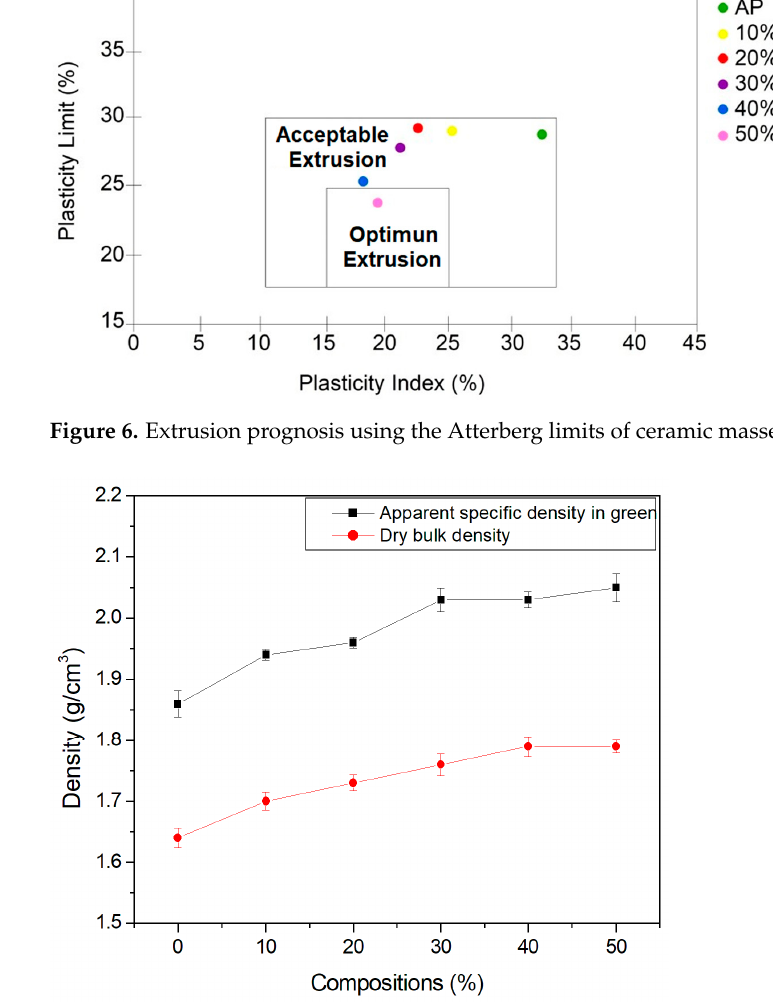
Figure 7. Green and dry specific density of the compositions.